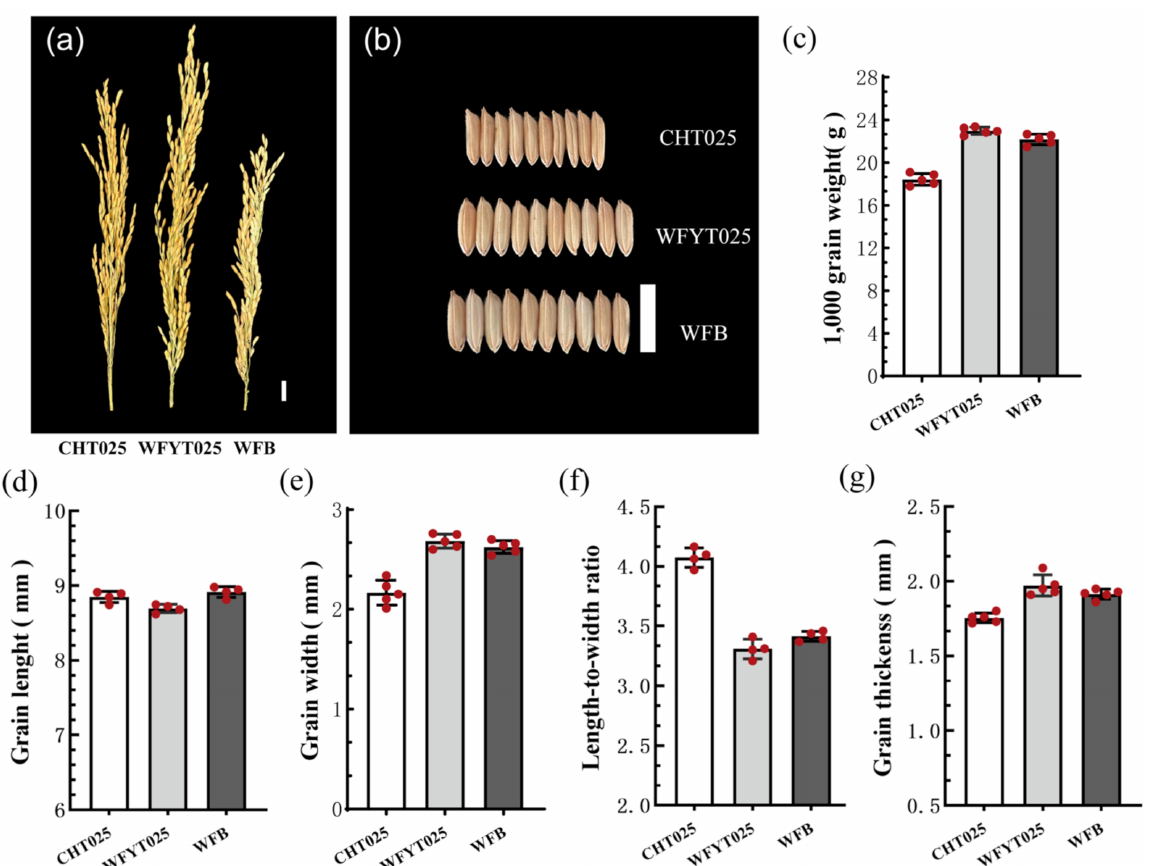
Figure 1. Heterosis in F 1 plants. ( a ) The panicle of F 1 plants and parental lines. Scale bar = 1 cm. ( b ) Grains of F 1 plants and parental lines. Scale bar = 1 cm. ( c – g ) The grain shape-related traits of F 1 plants and parental lines.